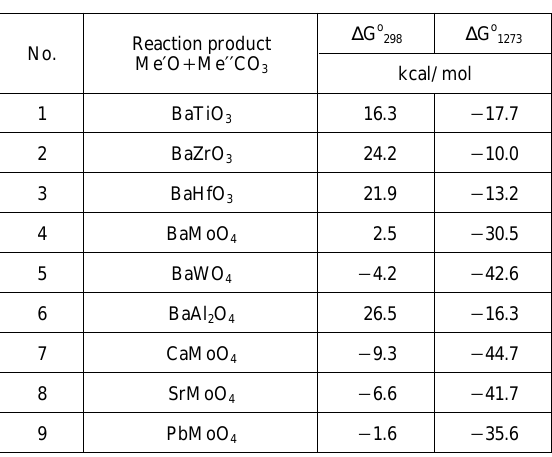
Table 1 Changes of Gibbs’ energy in the reactions of the mixtures of metal oxides and the metal oxides with metal carbon- ates resulting in the formation of complex oxides.